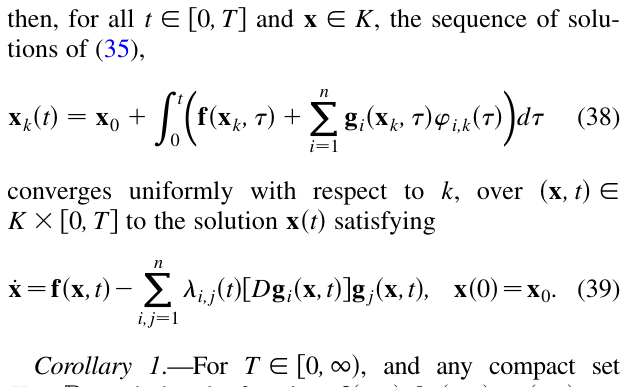
FIG. 16. Comparison of rms beam size along the accelerator for the 2011 tune-based magnet settings (dashed) and after the beam initial conditions have changed and RR tuning has refo- cused and matched the beam